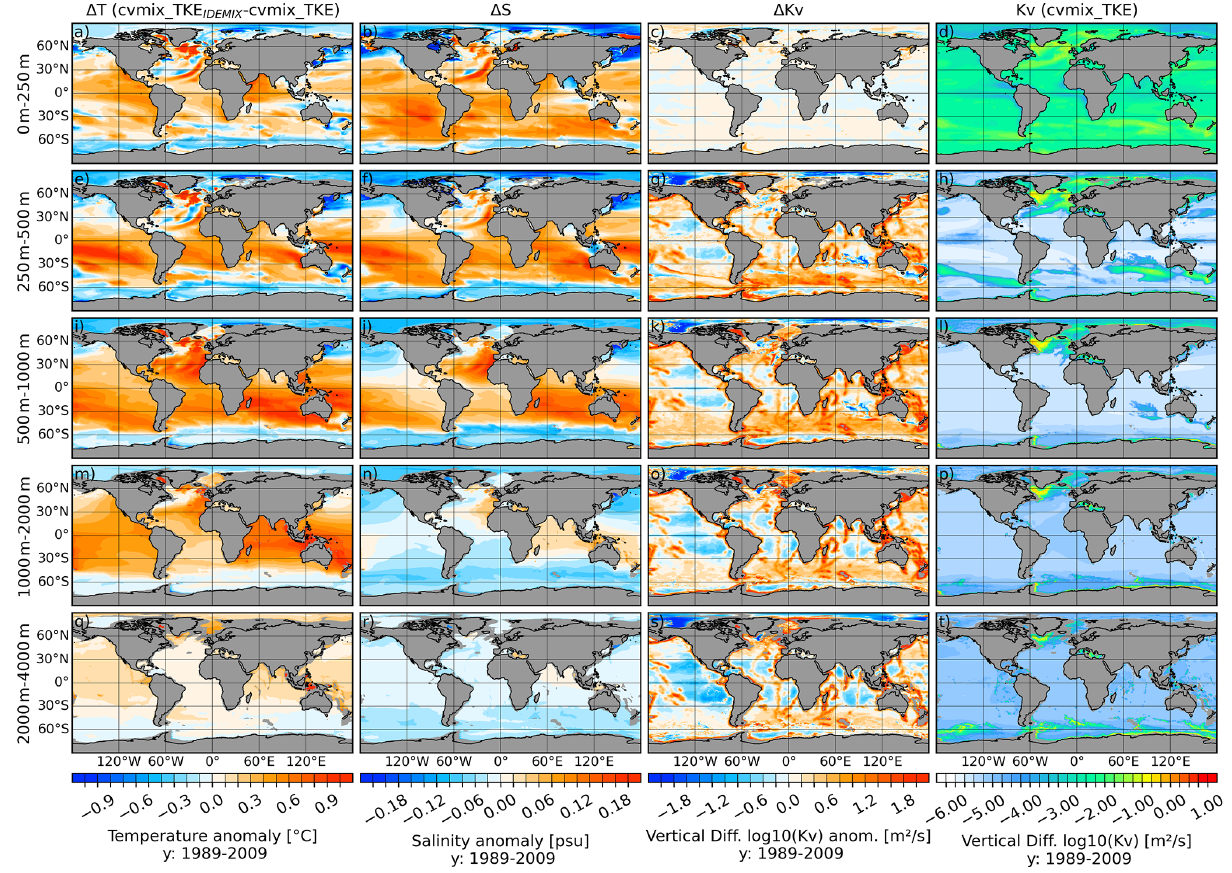
Figure 17. Temperature ( a, e, i, m, q ), salinity ( b, f, j, n, r ) and vertical diffusivity ( c, g, k, o, s ) difference between cvmix_TKE with and without IDEMIX and the absolute vertical diffusivity values ( d, h, l, p, t ) for cvmix_TKE without IDEMIX mixing averaged for the period 1989 to 2009. The panels show, from top to bottom, the vertically averaged fields for the depth ranges of 0–250, 250–500, 500–1000, 1000–2000 and